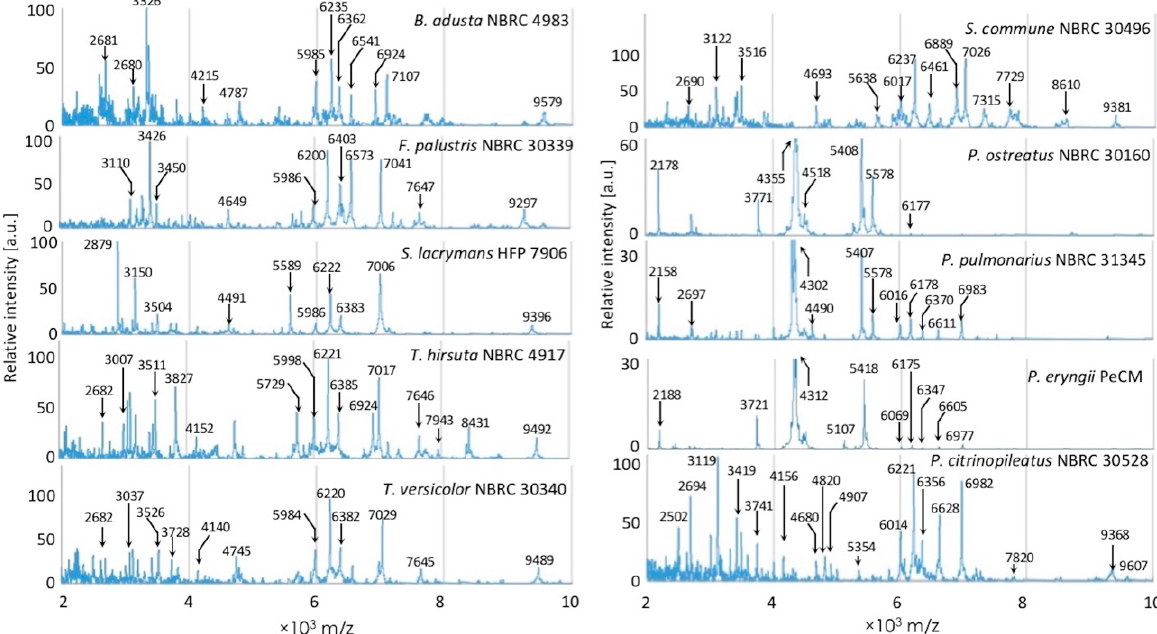
Figure 1. Raw mass spectra of representative strains of each species. Bjerkandera adusta , NBRC 4983; Fomitopsis palustris , NBRC 30339; Serpula lacrymans , HFP 7906; Trametes hirsuta , NBRC 4917; Trametes versicolor , NBRC 30340; Schizophyllum commune , NBRC 30496; Pleurotus ostreatus , NBRC 30160; Pleurotus pulmonarius , NBRC 31345; Pleurotus citrinopileatus , NBRC 30528. The y-axis indicates relative intensity of the recorded peaks; the x-axis shows the mass changes from 2000 to 10,000 Da. The comparisons of the MSPs within each species or genus are shown in Figures